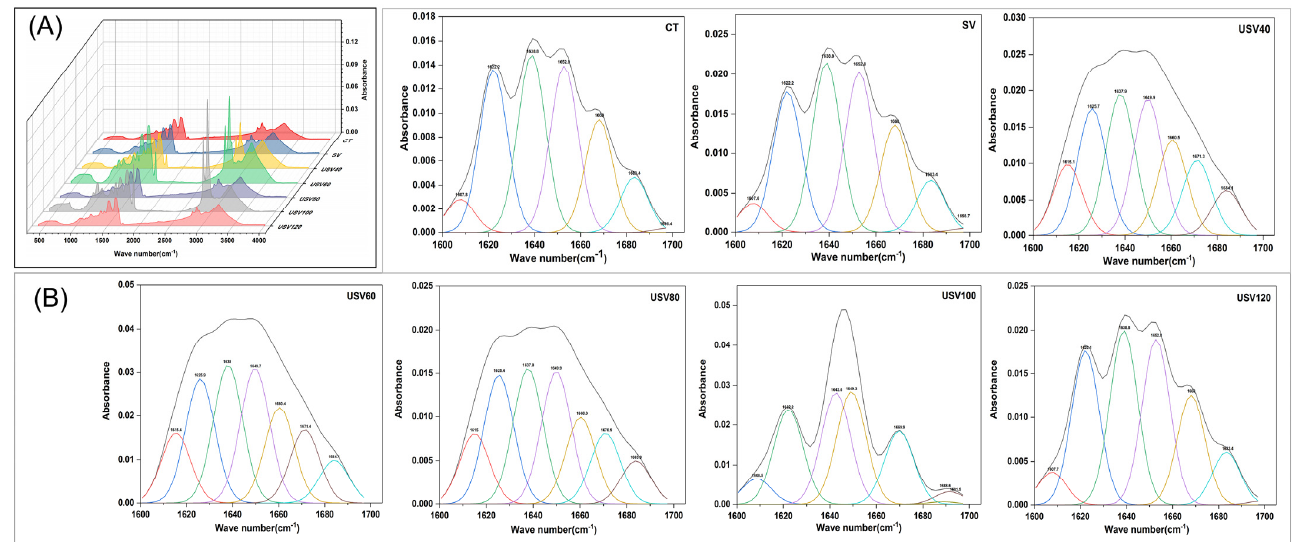
Figure 6. Infrared spectra of spiced beef proteins and fitted curve of protein amide I band of spiced beef under different thermal treatments. ( A ) Infrared spectra of spiced beef proteins; ( B ) fitted curve of protein amide I band of spiced beef.